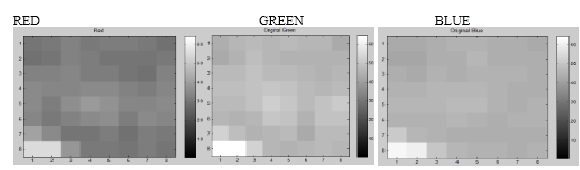
Figure 7. 32 × 32 pixels panchromatic